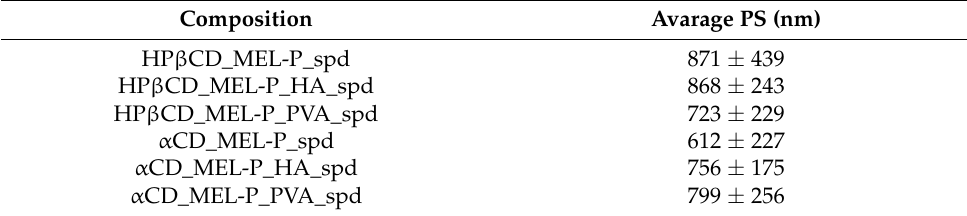
Figure 3. SEM images of the spray dried samples . The scale bar = 3.0 µm.